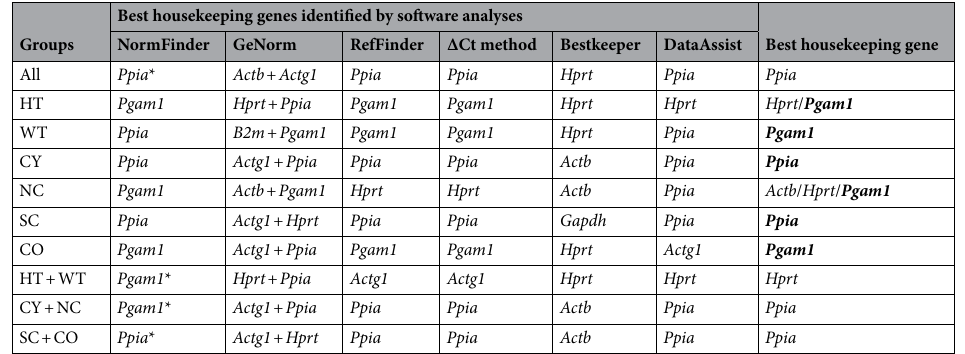
Table 1. Best housekeeping gene for each group of samples, each model and respective control, and all groups yielded by software analyses. *Best reference genes considering intra- and intergroup variations. All, all samples; HT, haploinsufficient; WT, wild type; CY, cystic; NC, noncystic; SC, severely cystic phenotype; CO, control for the severely cystic phenotype. NormFinder (version 0.953; https:// moma. dk/ normfi nder- softw are), GeNorm (version 2.2; https:// genorm. cmgg. be/), BestKeeper (version 1.0; https:// www. gene- quant ifica tion. de/ bestk eeper. html), DataAssist (version 3.01; https:// www. therm ofish er. com/ br/ en/ home/ techn ical- resou rces/ softw are- downl oads/ dataa ssist- softw are. html), the comparative ΔCt method and RefFinder (https:// www. heart cure. com. au/ reffi nder/). Genes in bold: higher frequency of appearance in